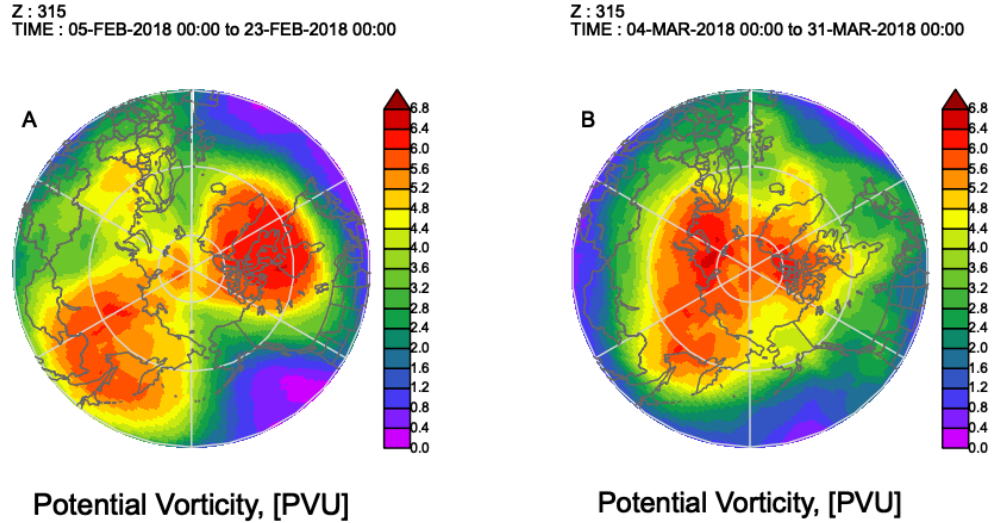
Figure 1. A 100 hPa geopotential height field (m, heights indicated by isolines and anomalies by color shadings relative to a 1981–2010 base period) for selected sub-periods from February–March 2018. Data are from NCEP–NCAR reanalysis.